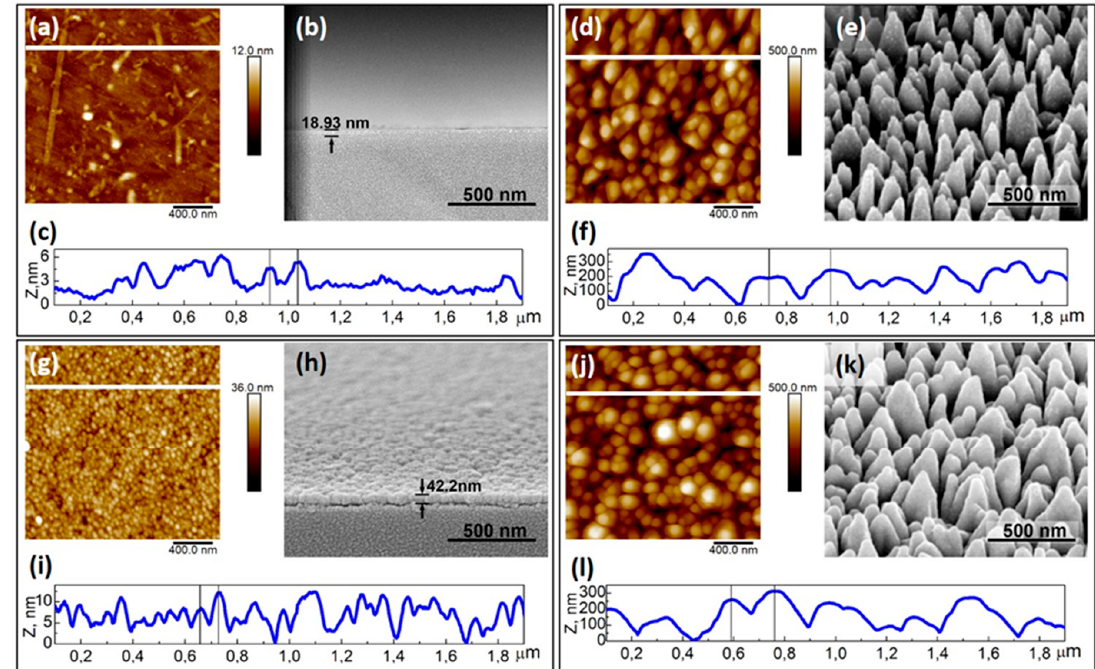
Figure 1. Typical two-dimensional AFM and SEM surface images of PyC of 20 nm ( a , b ) and 40 nm thickness ( g , h ) on SiO 2 , bSi ( d , e ), PyC of 20 nm on bSi ( j , k ), respectively. PyC layer is marked with arrows ( b , h ); ( c , f , i , l ) cross-sectional profiles of PyC (20 nm), bSi, PyC (40 nm), PyC (20 nm) on bSi from ( a , d , g , j ) AFM images, respectively. The cross-sectional profiles are marked with a white line on the AFM images ( a , d , g , j ).